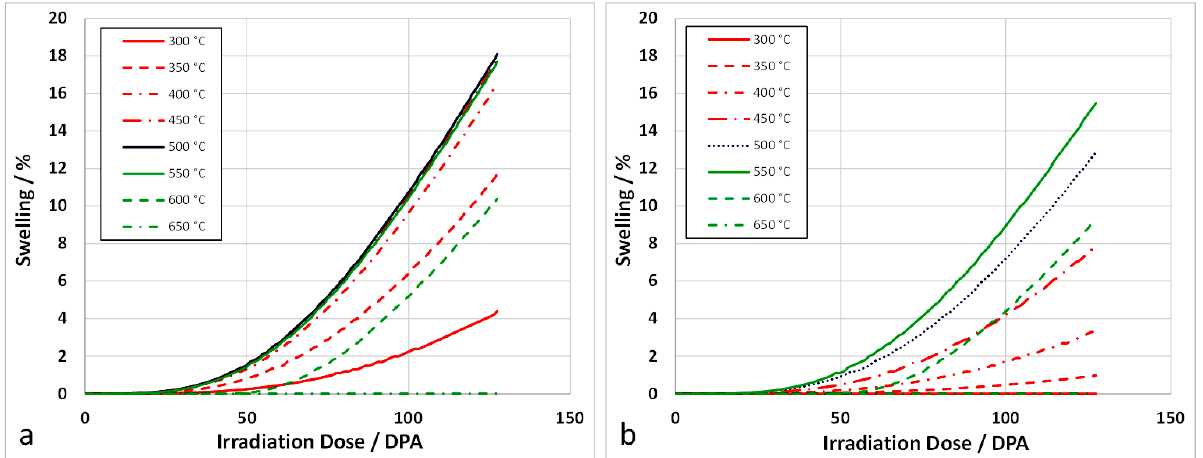
Figure 27. Calculated swelling for 316 SS as a function of dose in EBR-II (4.38 dpa per 10 22 n cm −2 ) for a cavity nucleation density of 10 20 m −3 and recombination coefficients of: ( a ) 10 20 × D i and ( b ) 100 × 10 20 × D i , where D i is the interstitial diffusion coefficient. The responses for different irradiation temperatures are illustrated. The dislocation density rises from ρ d = 2 × 10 14 m −2 in the cold-worked condition to 10 × 10 14 m −2 after irradiation to approximately 10 dpa. FMD production rate = 2.52 × 10 −8 dpa s −1 , He production rate ~0.27 appm/dpa; 30% interstitial bias for dislocations, vacancy formation energy = 1.6 eV, vacancy migration energy = 1.4 eV, interstitial migration energy = 0.15 eV.